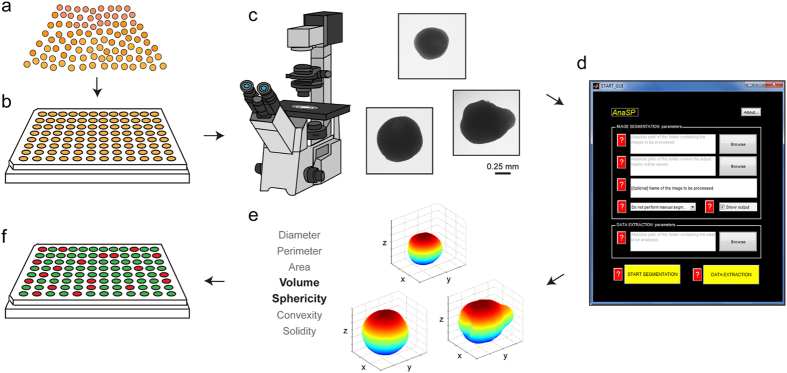
Schematic flow-chart of the image-based approach proposed to select a homogeneous population of large spheroids.(a) Spheroids of variable dimension and shape affect data reproducibility when they are used as an in vitro model to test drugs and radiotherapy treatments. (b) To select a sub-population of homogeneous spheroids, spheroids are seeded in low-attachment 96-well plates (one spheroid/well) and a brightfield image is acquired using an inverted widefield microscope (c). (d) AnaSP software (http://sourceforge.net/p/anasp/) can be used to automatically compute (e) several morphological parameters (3D reconstructions obtained by using ReViSP, http://sourceforge.net/p/revisp/). (f) A sub-population of homogeneous spheroids can be selected by analyzing volume and sphericity. The plate wells containing spheroids with similar volume and sphericity are shown in green.